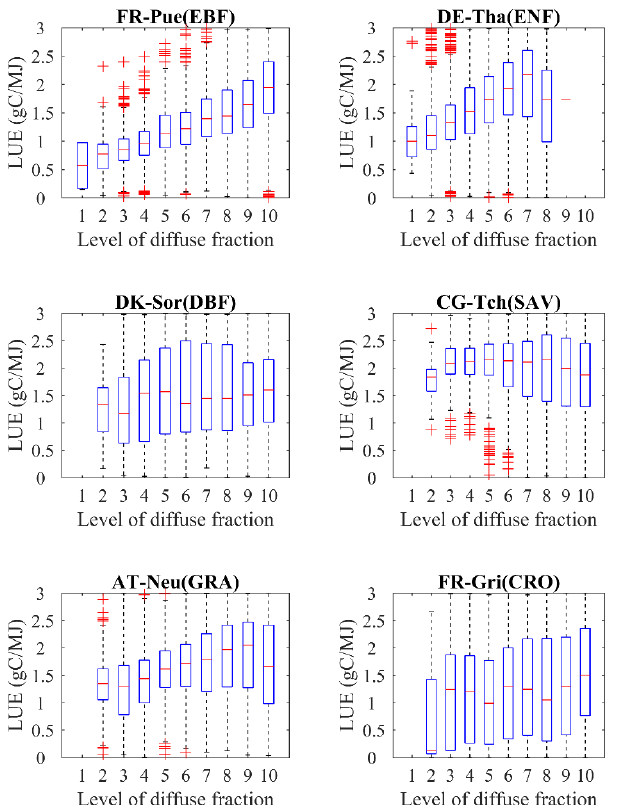
Figure 2. Temporal variations of LUE under different levels of diffuse radiation fraction at FLUXNET sites (The level of diffuse fraction denotes the values of diffuse fraction varying from 0 to 1 with 0.1 intervals). 0.1